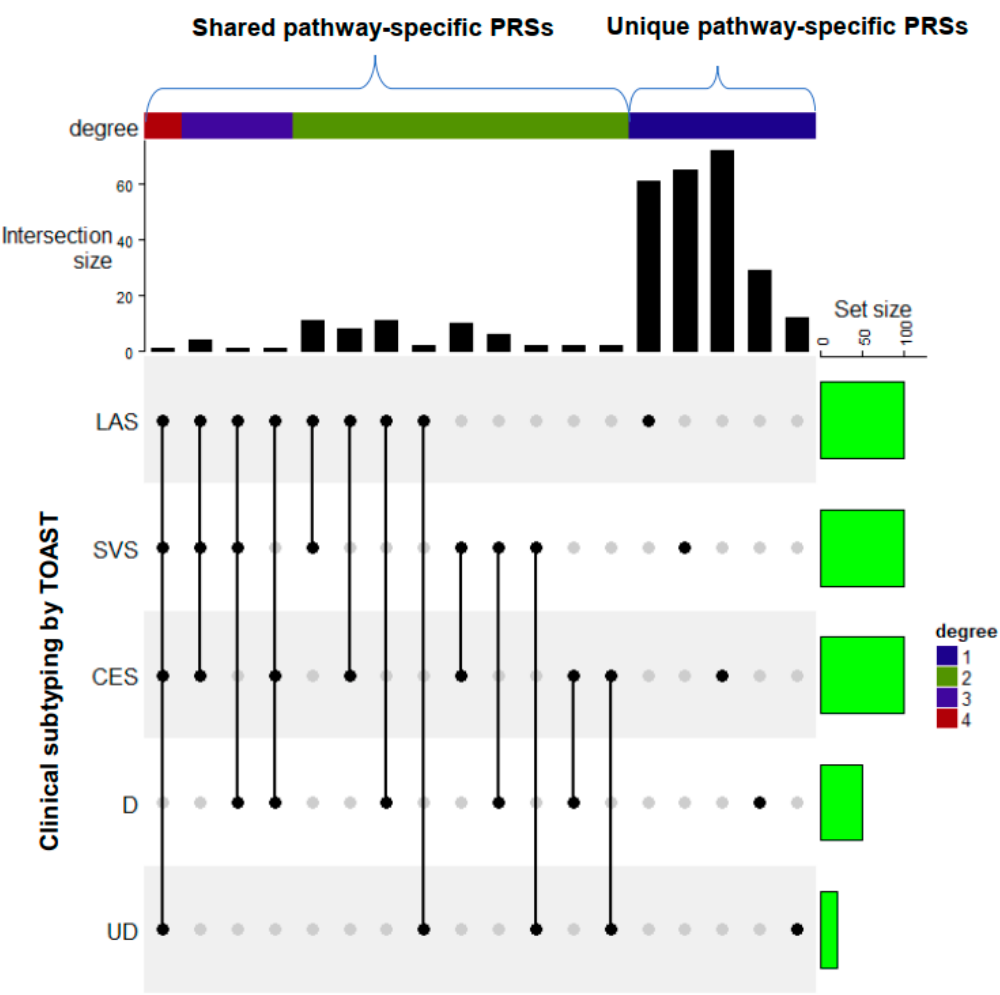
Figure 6. A modified paradigm of IS risk stratification beyond TOAST subtyping using simulated data. Based on the pilot study, we assume a total of 700 valid pathway-specific PRSs are available for a subtype-specific association study. The horizontal bar plot represents the size of PRSs with significant association with the corresponding TOAST subtypes. TOAST subtypes include (1) cardiac embolism (CES), (2) stroke of other determined etiology (DETERMINED (D)), (3) large artery stroke (LAS), (4) small vessel stroke (SVS), and (5) stroke of undetermined etiology (UNDETERMINED (UD)). We assume 100 out of 700 pathway-specific PRSs showed at least minimal significance for LAS, SVS, and CES. However, this set size was assumed to be dramatically decreased for D and UD due to small sample size and less heritability for U or advanced heterogenicity for D. The vertical bar plot represents the number of pathway-specific PRSs shared between at least two TOAST subtypes or unique to individual subtypes. The intersect pathways (distinct mode) across some or all clinically defined subtypes and the unique pathways toward each subtype could help to create new risk stratification procedures.